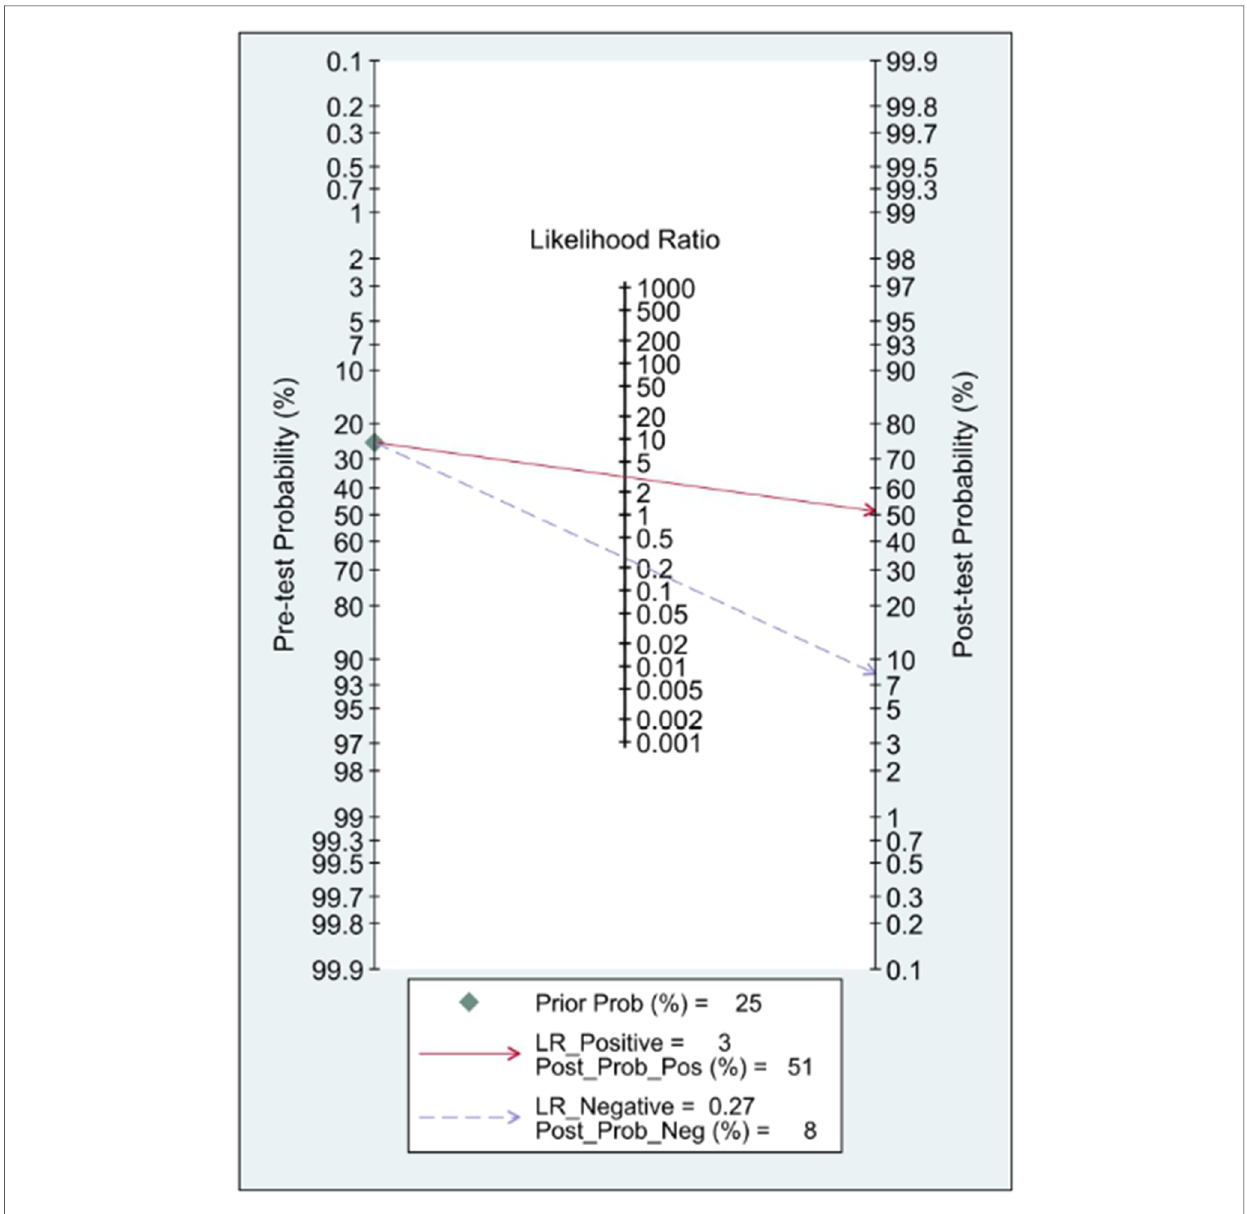
FIGURE 8 Fagan ’ s Nomogram for assessment of post-test